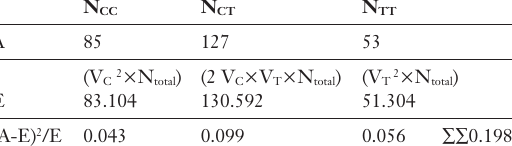
The statement for Hardy-Weinberg equilibrium about the allele and genotype frequencies of the MDR1 C3435T .